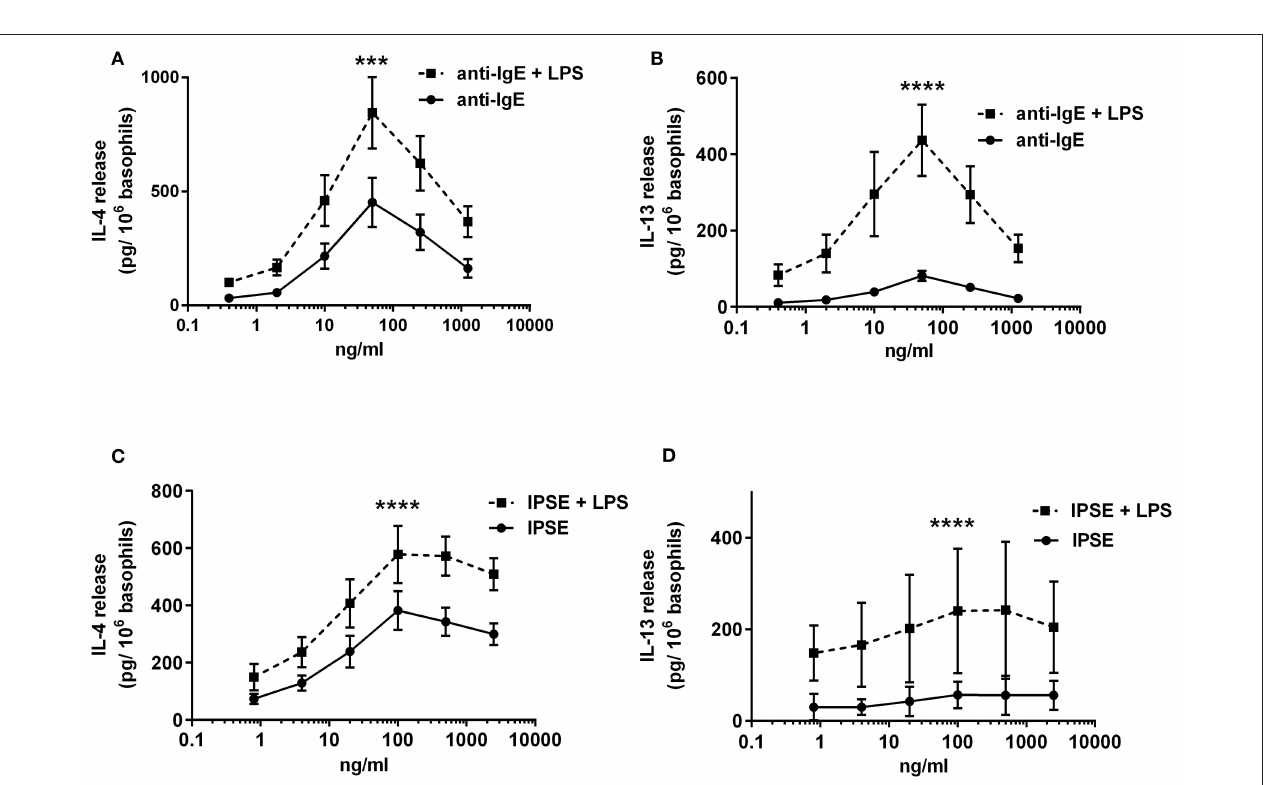
FIGURE 9 | Enhanced Fc ε RI-dependent IL-4 and IL-13 release from basophils by simultaneous stimulation with LPS ( via TLR4). IL-4 (A,C) and IL-13 (B,D) release from basophils stimulated anti-IgE ± LPS (A,B) , or IPSE/alpha-1 ± LPS (C,D). Data are presented as mean ± SEM; (A) n = 7; (B) n = 5; (C) n = 9; (D) n = 4. Statistics data were performed by ratio paired t -test; significance is shown as with vs. without LPS; *** p < 0.001, **** p <